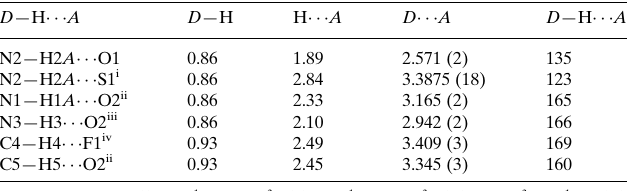
Hydrogen-bond geometry (A˚ , (cid:2)